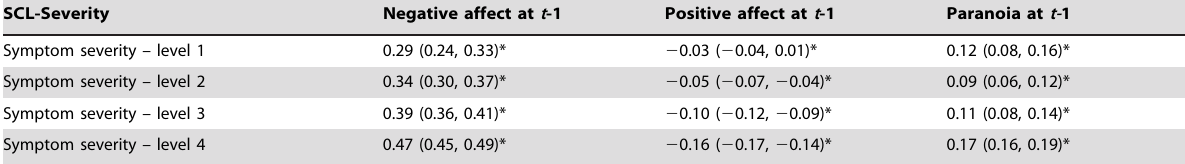
Negative affect at moment t predicted by mental states at moment t -1, by SCL-severity